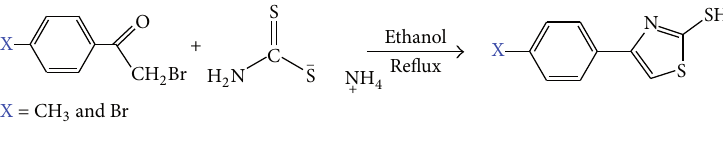
F 2: Synthetic route for the mercaptothiazole derivatives structure.